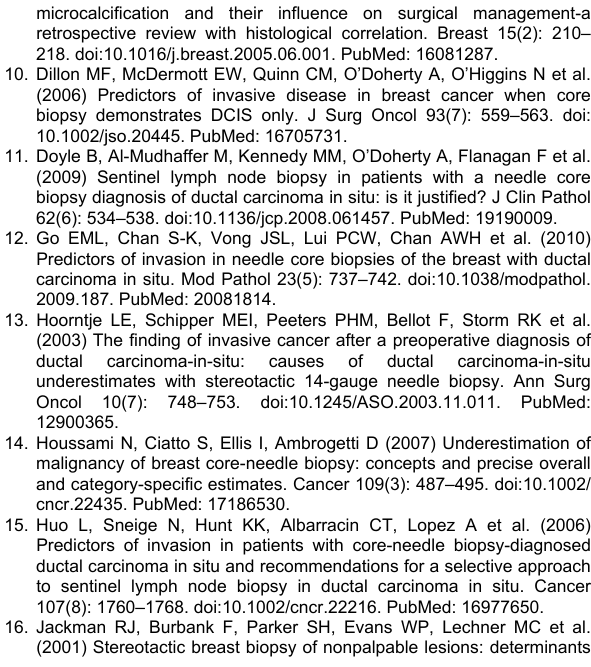
Table S1. Table of missing value